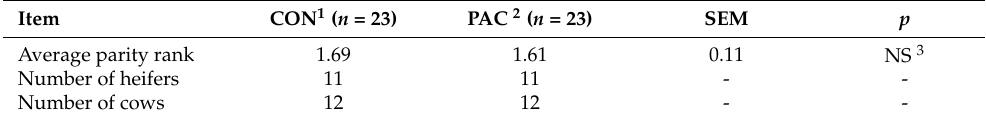
Table 6. Randomization of the experimental cows (mean values and standard errors of the mean).